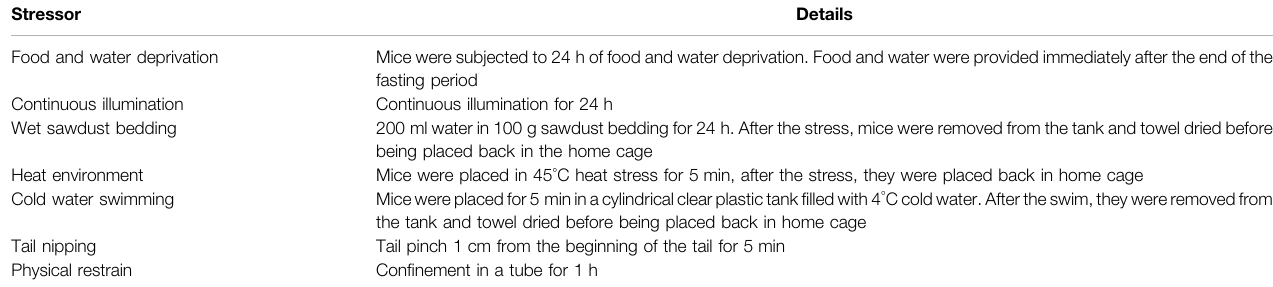
TABLE 1 | Chronic unpredictable mild stress (CUMS)